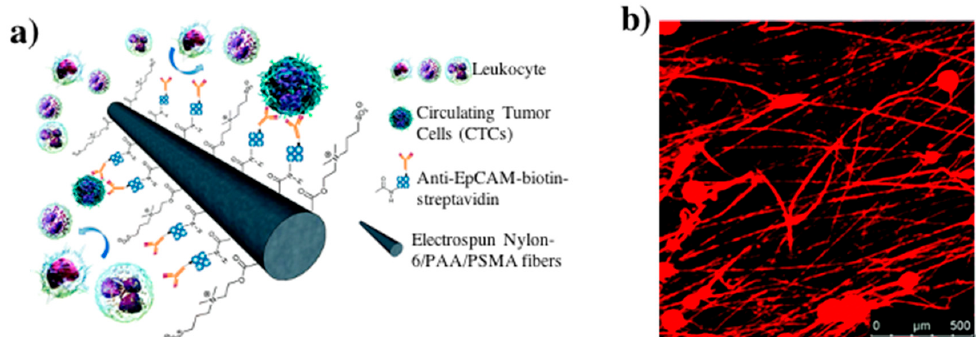
Figure 3. ( a ) Schematic representation of CTC capture of electrospun triple-blend fibrous mats from blood specimens, with repulsive ability against leukocyte adsorption. ( b ) Confocal images of Fluorescein isothiocyanate (FITC)-streptavidin-modified after the immunosorbent reaction with Cy5-biotin [41] . Reproduced by permission of The Royal Society of Chemistry.